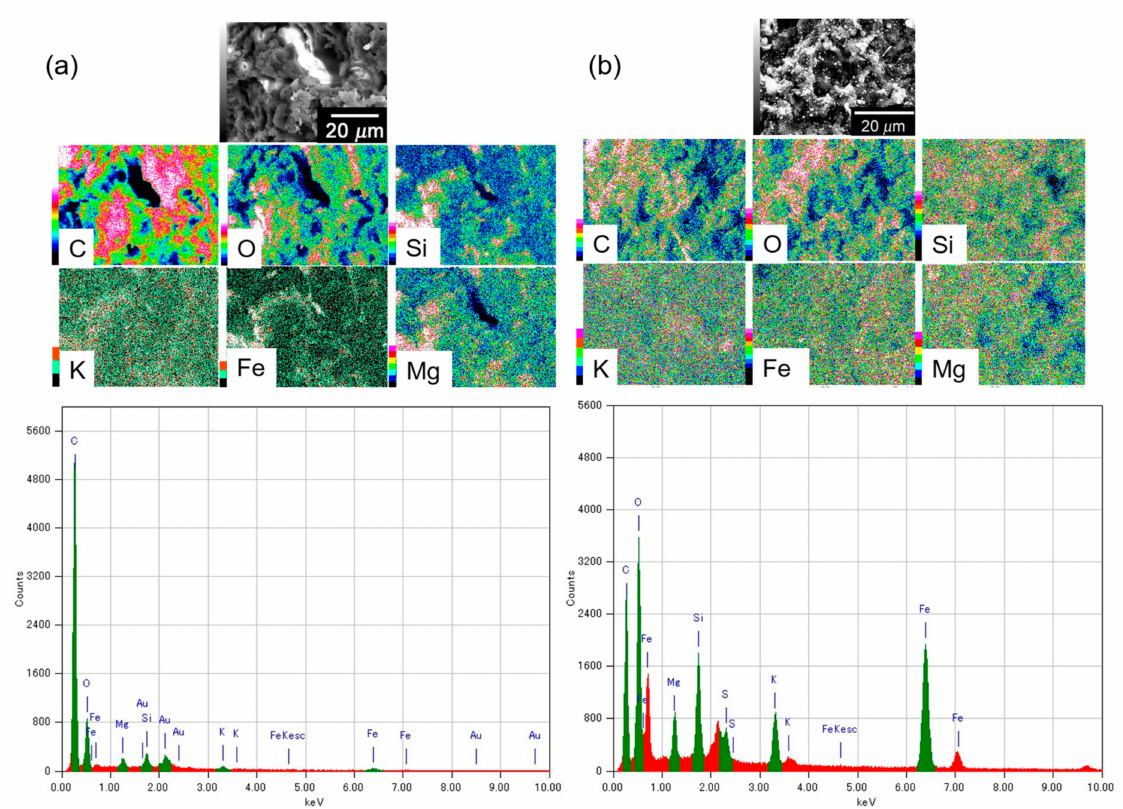
Figure 4. Energy dispersive X-ray spectroscopy (EDS) analysis of B. braunii residues: ( a ) before carbonization; ( b ) carbonized at 900 ◦